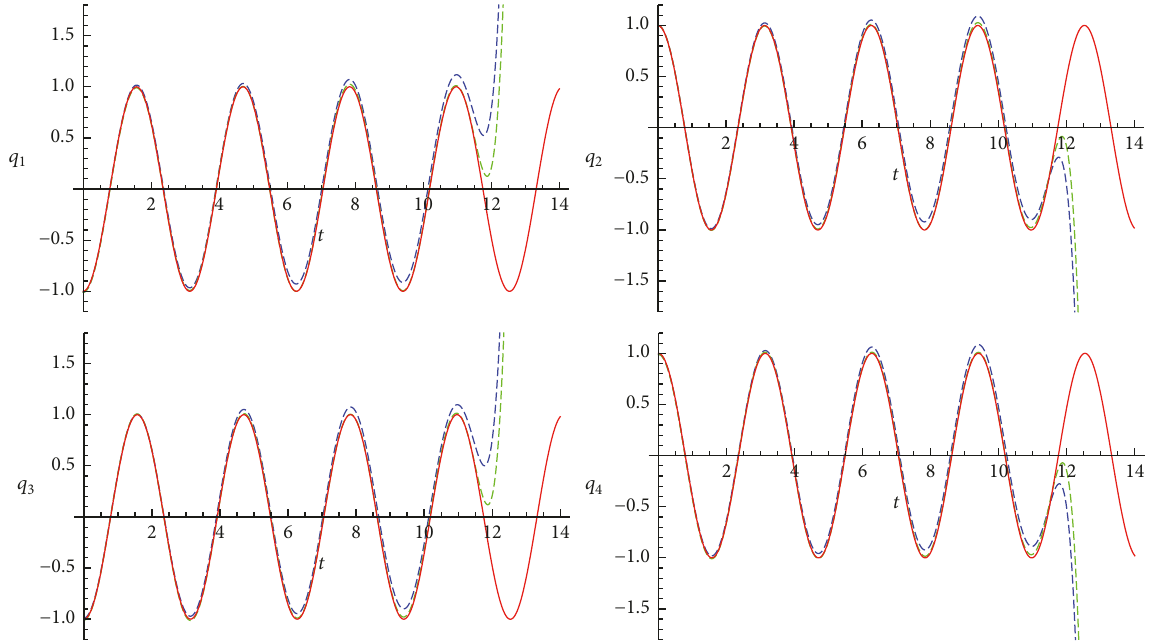
Figure 1: The curves of solutions of (5): the red curve is an approximate 𝜋 -periodic solution starting from 𝑃 1 , while the blue dashed curve and the green dashed curve are the reference solutions starting from 𝑄 11 and 𝑄 12 ,